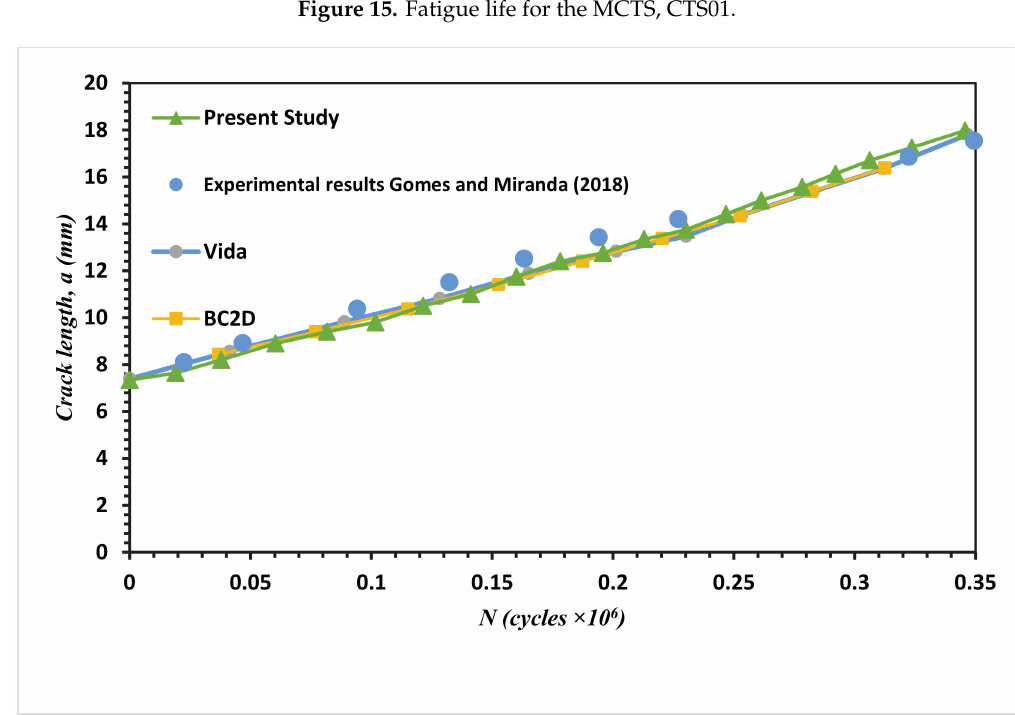
Figure 16. Fatigue life for the MCTS,